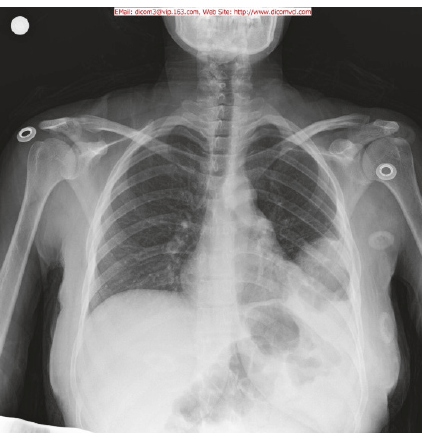
Figure 1: A herniated bowel loop in posteroanterior chest X-ray.